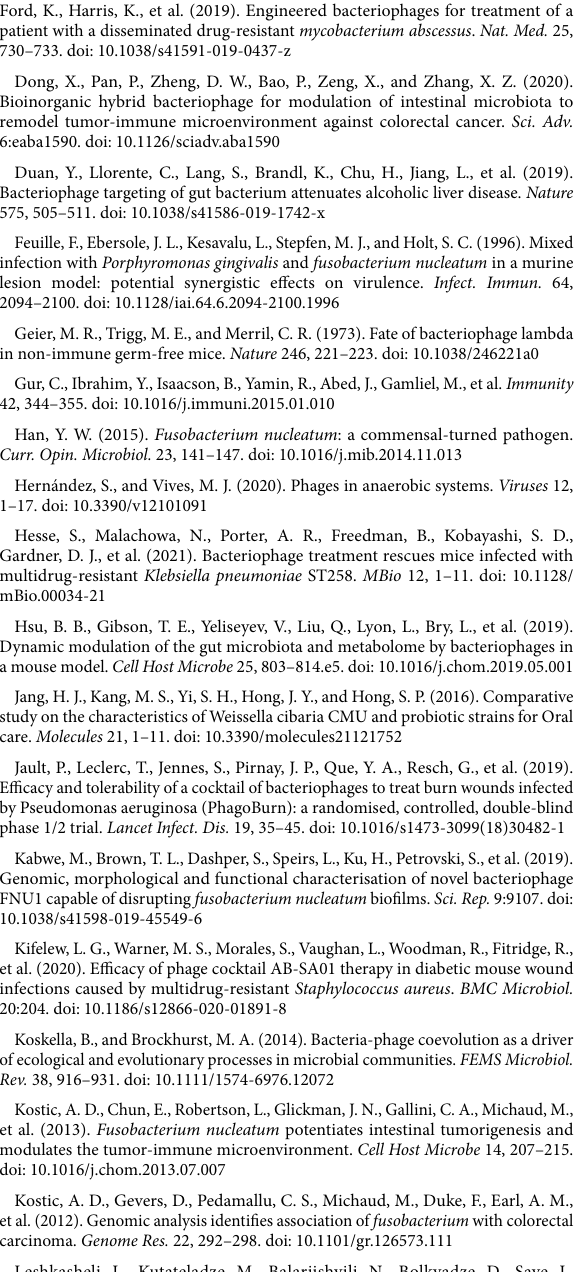
created with the default parameter value based on the results of conserved domain search ( e = 0.0001), which showed the presence or absence of the CDD in the phage-related genome. The horizontal axis represents phage genomes, and the vertical axis represents conserved domains. JD-Fnp1 ~ JD-Fnp5 are new F. nucleatum bacteriophages discovered in this study, which are shown in red. FNU1 and φ Funu1 are reported F. nucleatum phages with whole-genome sequence data and are shown in blue. Other bacteriophages are displayed according to their serial numbers in IMG/VR